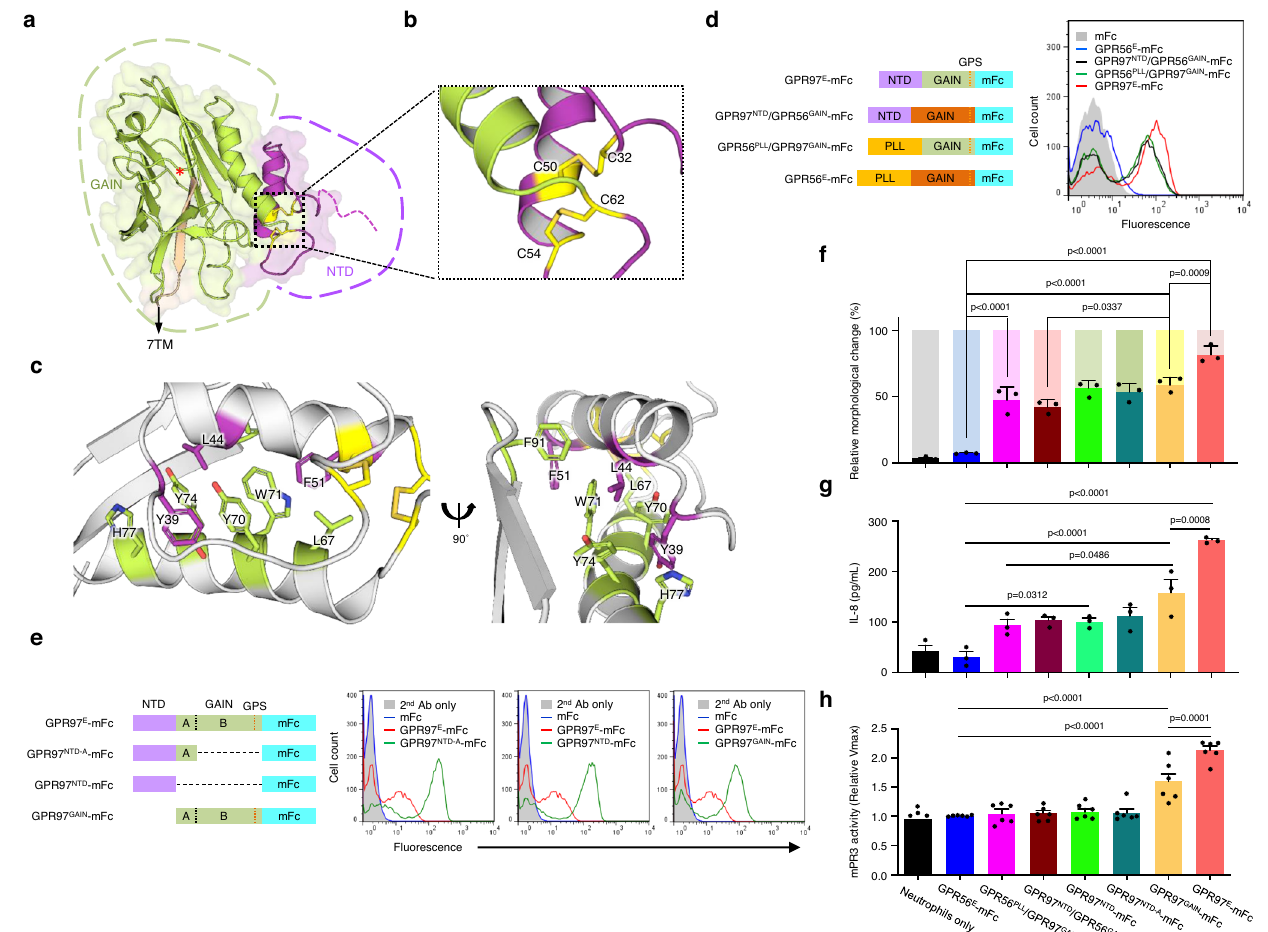
Fig. 4 | Structural analysis of GPR97-ECR and mapping of the mPR3-binding regions.a CartoonrepresentationoftheGPR97-ECRstructureobtainedfromX-ray crystallography experiments. The NTD is depicted in purple and the GAIN domain in green and beige (the 13 th β -strand). Cysteine residues involved in linking and stabilising the NTD are shown as yellow sticks. The red asterisk indicates the GPS cleavagesite. b Close-upofthetwodisulphidebridges,C32-C50andC54-C62, that are involved in the stabilisation of the NTD and GAIN domains. c Close-up on the extensive hydrophobic interactions stabilising the packing of the NTD against the GAIN domain. Residues from the NTD are depicted in purple and those from the GAIN domain are depicted in green. d , e Mapping of the mPR3-binding region(s)